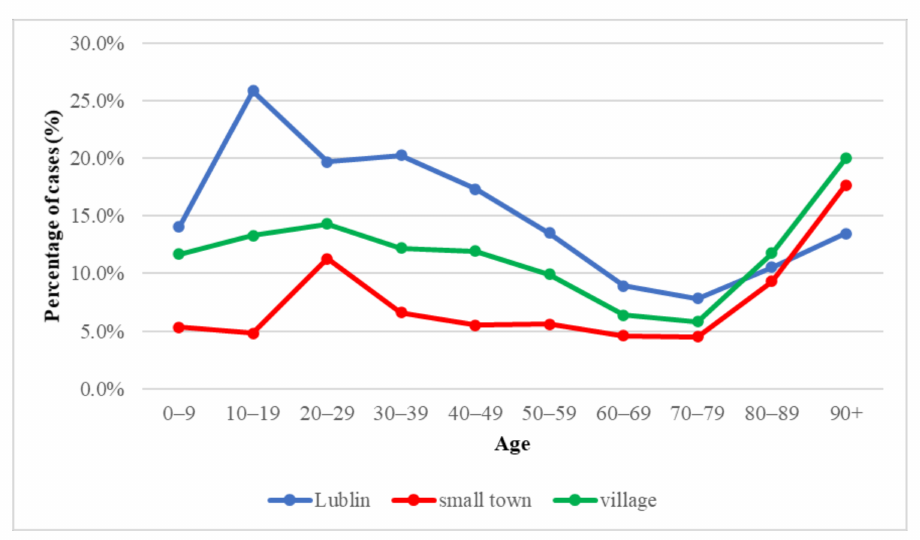
Figure 1. SARS CoV-2 infection by age and place of